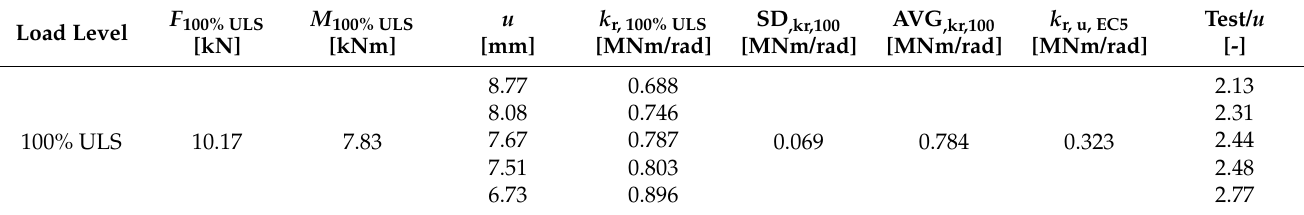
Table 11. Results of quasi ‐ static cyclic testing for Experiment B at 100% ULS.